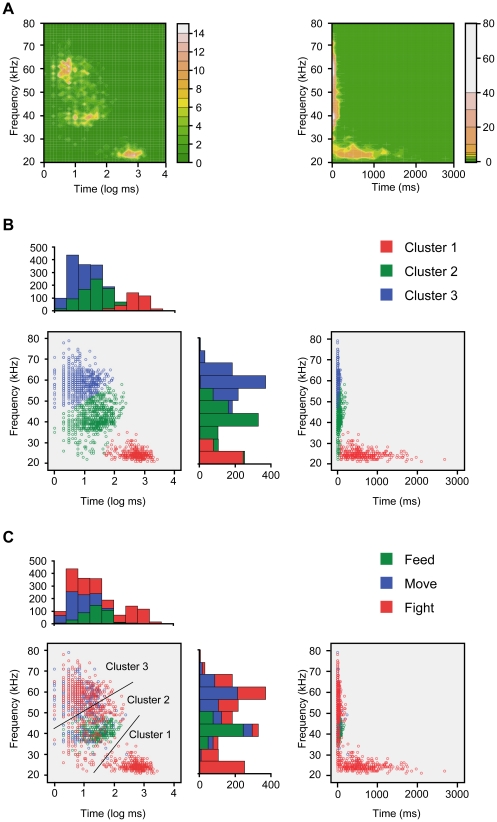
Scattar plots of cluster and behavior.(A) Power graph and (B) scatter plot of frequency vs. duration of USV calls. A total of 1785 USV calls from the three pairs were aggregated. USV calls were separated into three cluster groups. (C) The same data shown in (B) was color-coded by behavioral categories. Left: log transformed data. Right: nonlog transformed data.